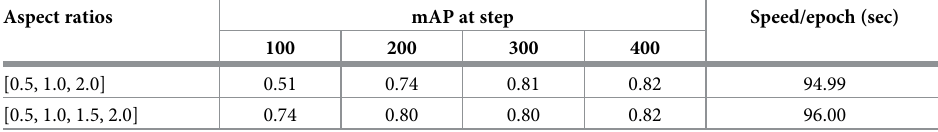
Performance comparison by mAP of the models trained using two possible aspect ratios. This performance was evaluated at 100, 200, 300, and 400 steps, and the training time per epoch for each configuration is shown in seconds. In object detection systems, the bounding boxes in an image can assume different shapes, reflected by the aspect ratios of those bounding boxes. An additional aspect ratio was used to create initial bounding boxes that could potentially improve the fit to the cells’ morphology.